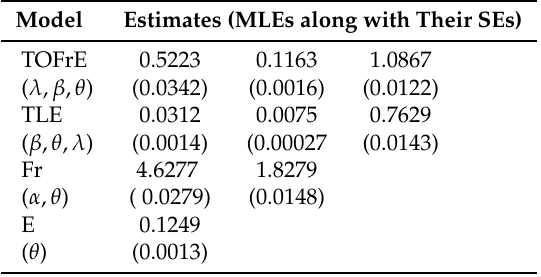
Table 13. MLEs and SEs of the models for Data set III.